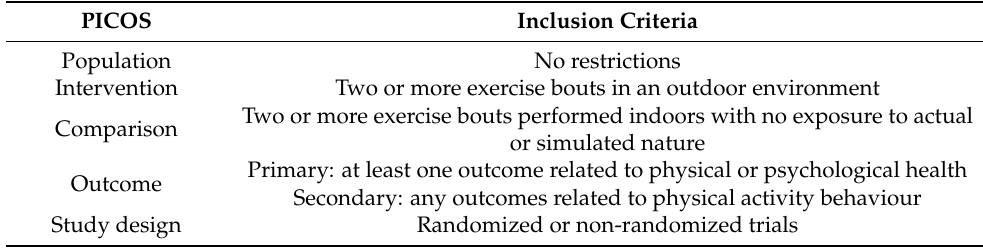
Table 2. PICOS eligibility criteria for the current systematic review.